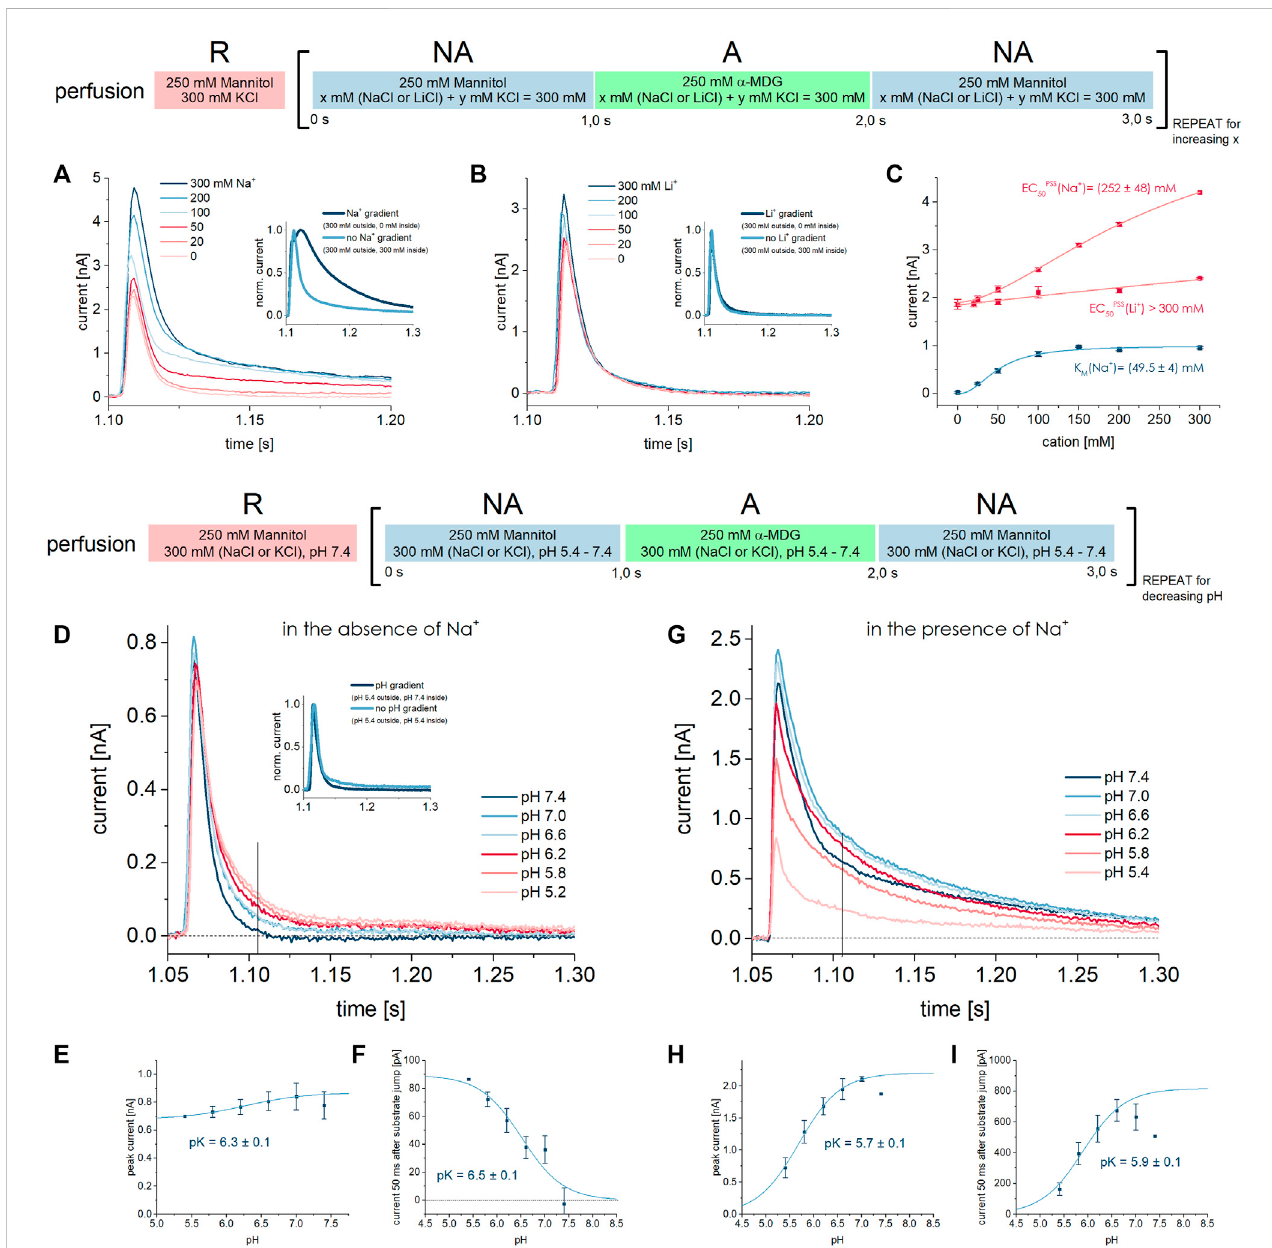
FIGURE 7 Effect of Na + , Li + , and H + on PSS and transport currents. All current traces were recorded in the presence of different Na + , Li + or H + concentrations in all measurement solutions upon 250 mM MDG concentration jumps. Averaged data of n = 5 different sensors is shown. (A) Current traces were recorded at pH 7.4 in the presence of different Na + concentrations in all measurement solutions. The inset compares the current trace where Na + is only available in the external NA and A solutions and absent in the internal R solution (dark blue trace), leading to an inward directed Na + gradient and consequently to an increased transport phase. (B) Same as (A) but with different Li + concentrations as indicated. The inset shows that a Li + gradient does not affect the current trace. (C) Li + and Na + dependent peak currents and currents 50 ms after substrate jump are fi tted using a hyperbolic equation to derive EC 50 PSS or K M values, respectively. The PSS peak current observed in the Li + dataset at 0 mM Li + was normalized to the PSS peak current observed in the Na + dataset at 0 mM Na + . The EC 50 PSS for Li + could only be estimated to be > 300 mM. (D) Current traces were recorded in the absence of Na + at different pH values as indicated. The inset shows that a H + gradient does not affect the current trace. The vertical line indicates the time point at which the transport current is measured. (E) PSS peak currents are fi tted using the titration equation I(t) = I max /(1 + 10 ^ (pK-pH) ) to determine an apparent pK of 6.3 ± 0.1 for MDG binding in absence of Na + . (F) Currents 50 ms after substrate jump are fi tted using the titration equation I(t) = I max /(1 + 10 ^ (pH-pK) ) to determine an apparent pK of 6.5 ± 0.1 for H + /MDG cotransportinabsenceofNa + . (G) Currenttraceswererecordedinthepresenceof300 mMNa + atdifferentpHvaluesasindicated. Theverticallineindicatesthe timepointatwhichthetransportcurrentismeasured. (H) PSSpeakcurrentsare fi ttedusingthetitrationequationI(t)=I max /(1+10 ^ (pK-pH) )todetermineanapparent pKof5.7± 0.1 for MDG binding inthepresenceofNa + . (I) Currents50 msafterthesubstratejumpare fi ttedusing thetitrationequationI(t)= I max /(1 + 10 ^ (pK-pH) )to determine an apparent pK of 5.9 ± 0.1 for H + /MDG cotransport in the presence of Na +